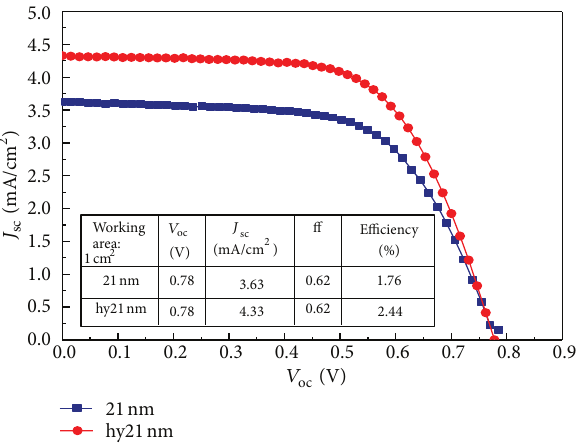
Figure 4: The 𝐼 - 𝑉 curve of dye-sensitized solar cells with the TiO 2 prepared by hydrothermal method and commercial